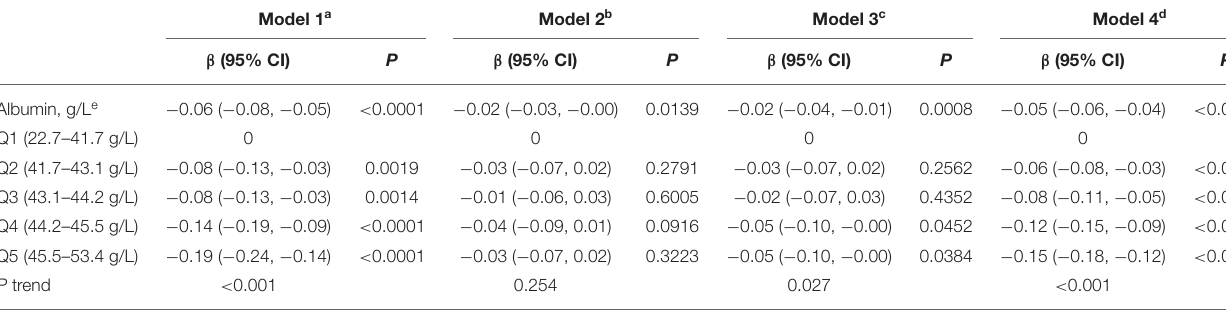
TABLE 3 | Multivariate analysis of the association of serum albumin levels with HbA1c.